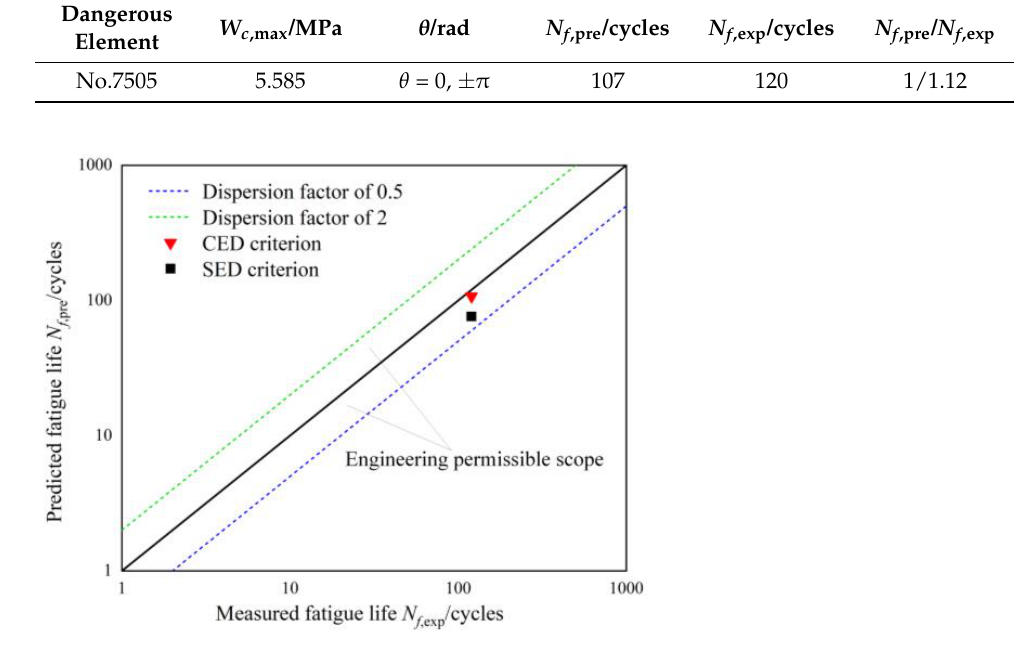
Figure 13. Comparison between the CED and SED criterion to predict flexible joint fatigue life.